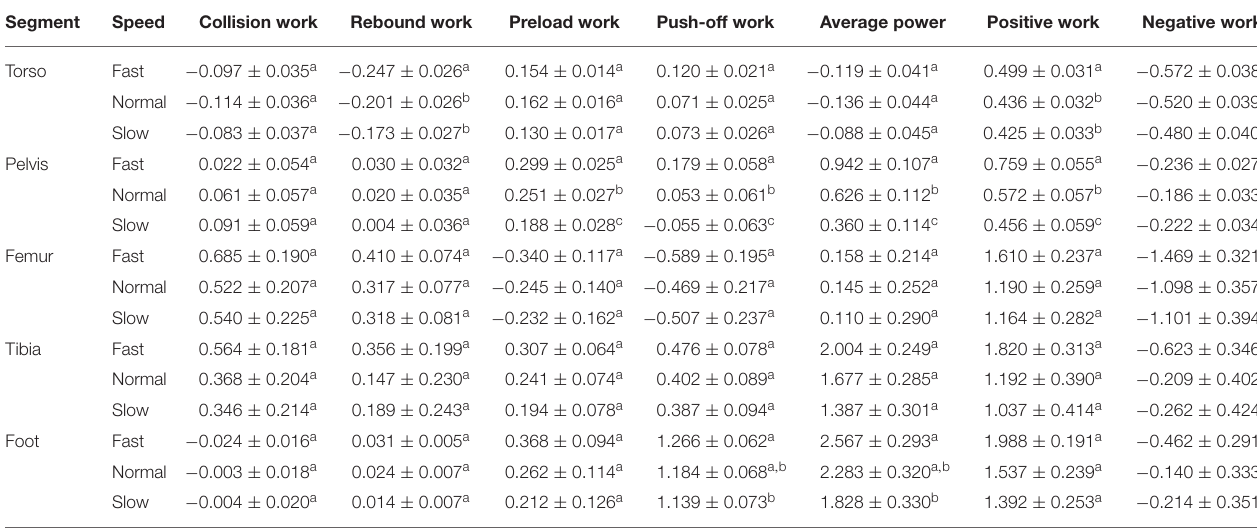
TABLE 2 | Mechanical energy change of segments during different